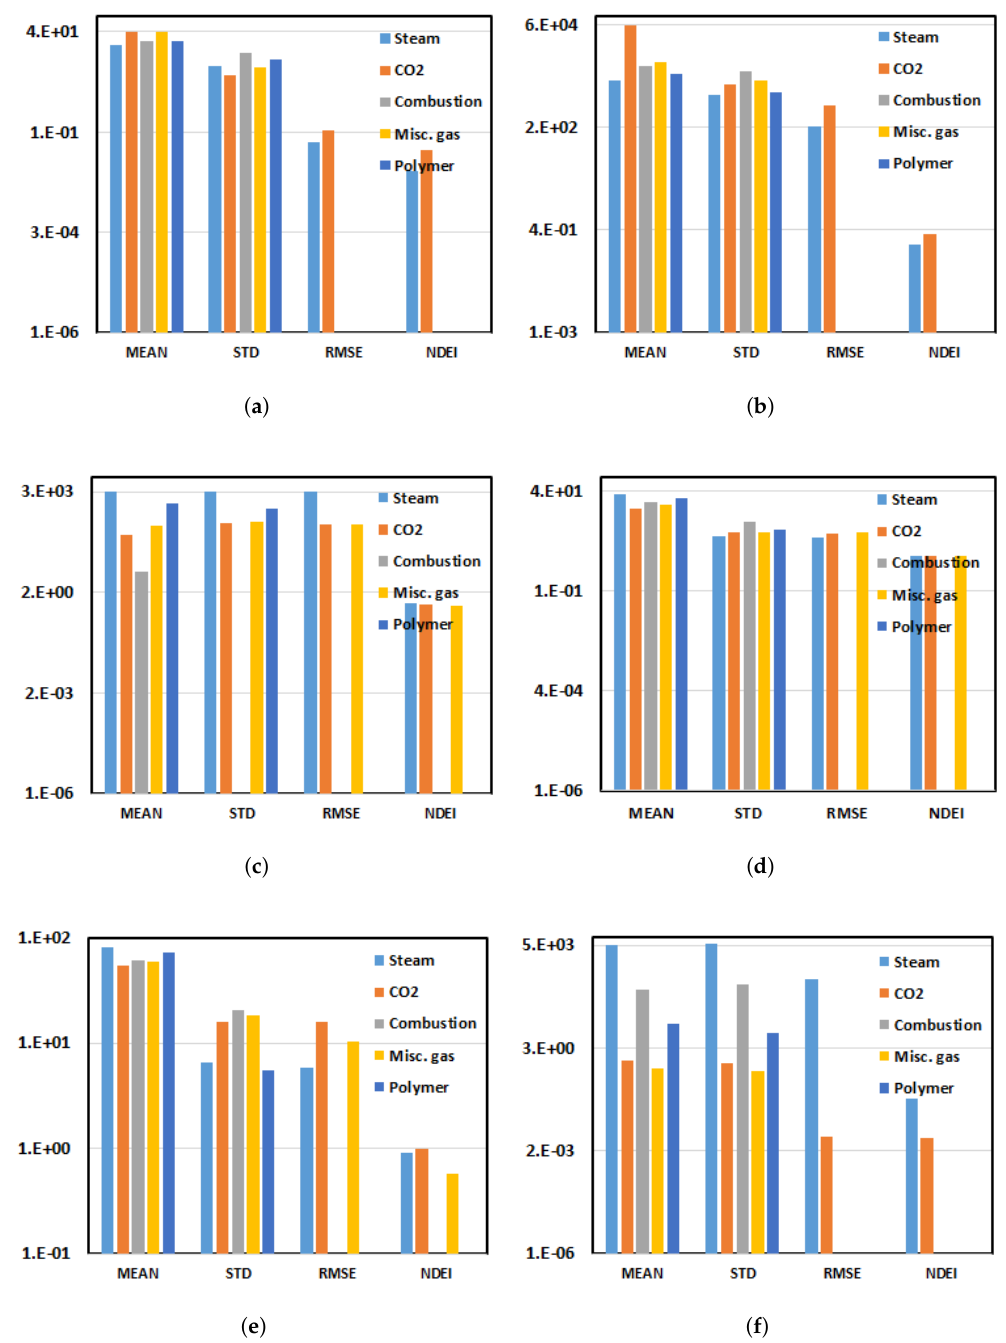
Figure A8. Statistical data plots of steam, CO 2 , combustion, miscible gas and polymer injection for Area 3 of the Angolan oilfield (See Table 4 for the area clarification). Variables include: ( a ) API; ( b ) depth; ( c ) permeability; ( d ) porosity; ( e ) saturation; and ( f )